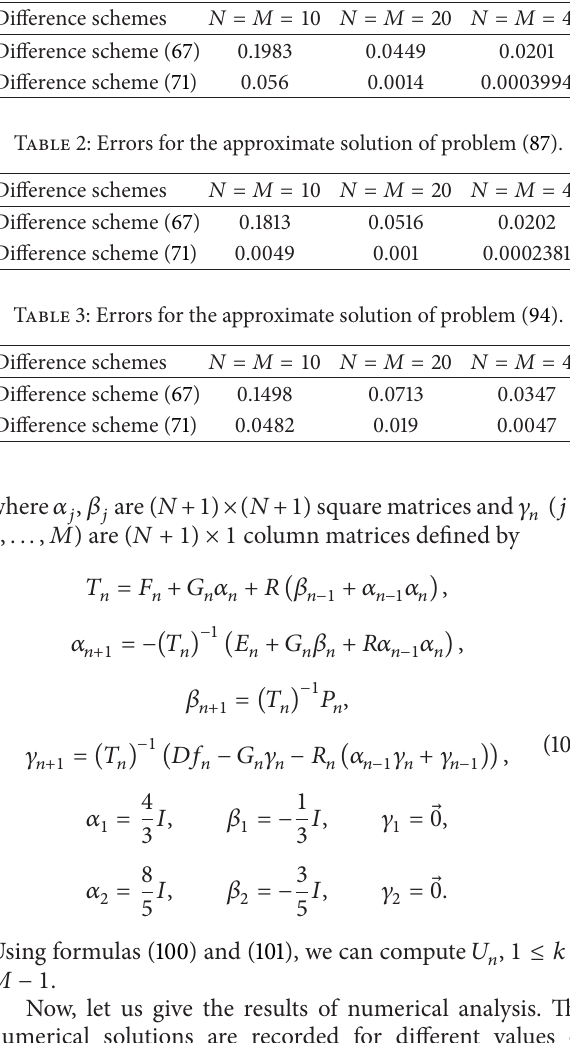
Table 1: Errors for the approximate solution of problem (73). Difference schemes